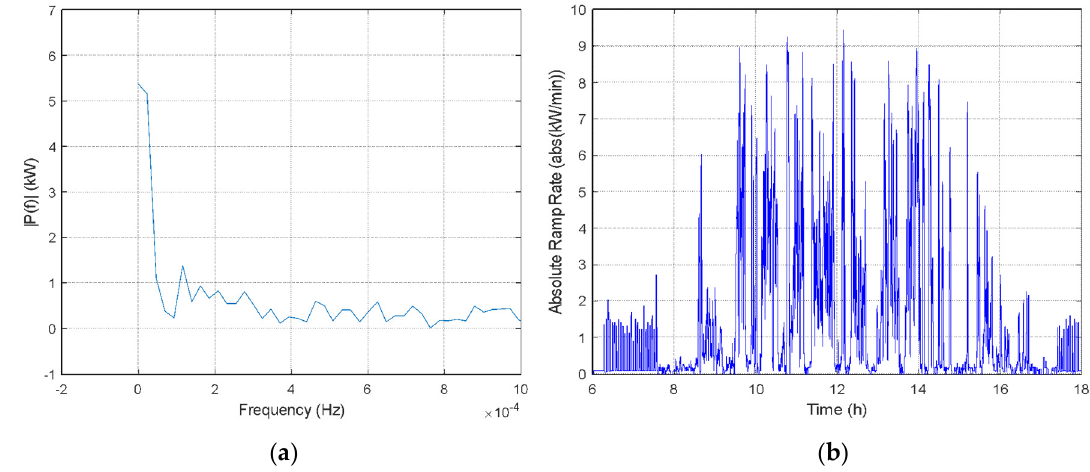
Figure 3. ( a ) Spectral behavior of power generation and ( b ) dynamic behavior of power generation of the PV system under study.